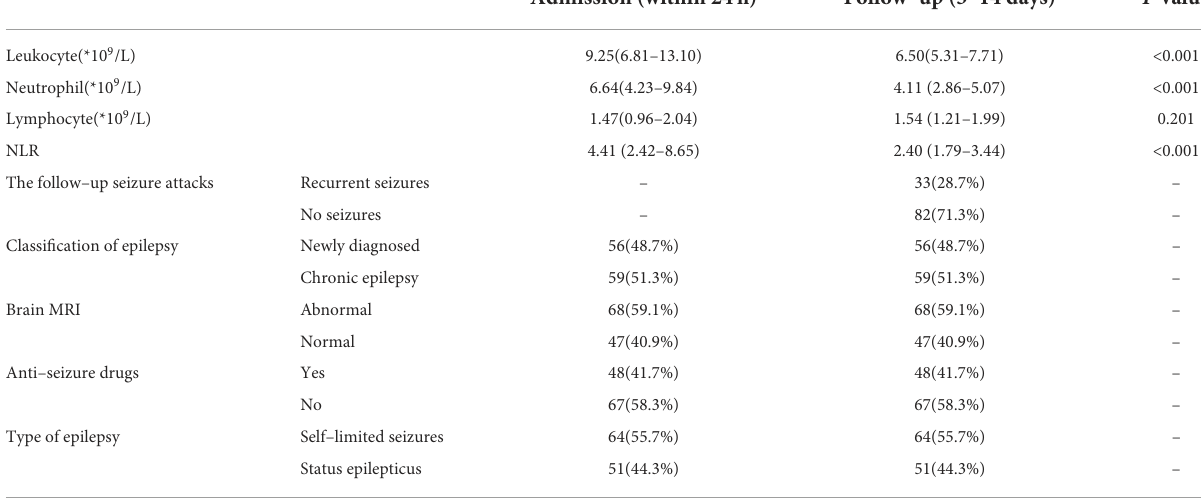
TABLE 4 Comparisons of laboratory and clinical characteristics between admission and follow–up period in patients with